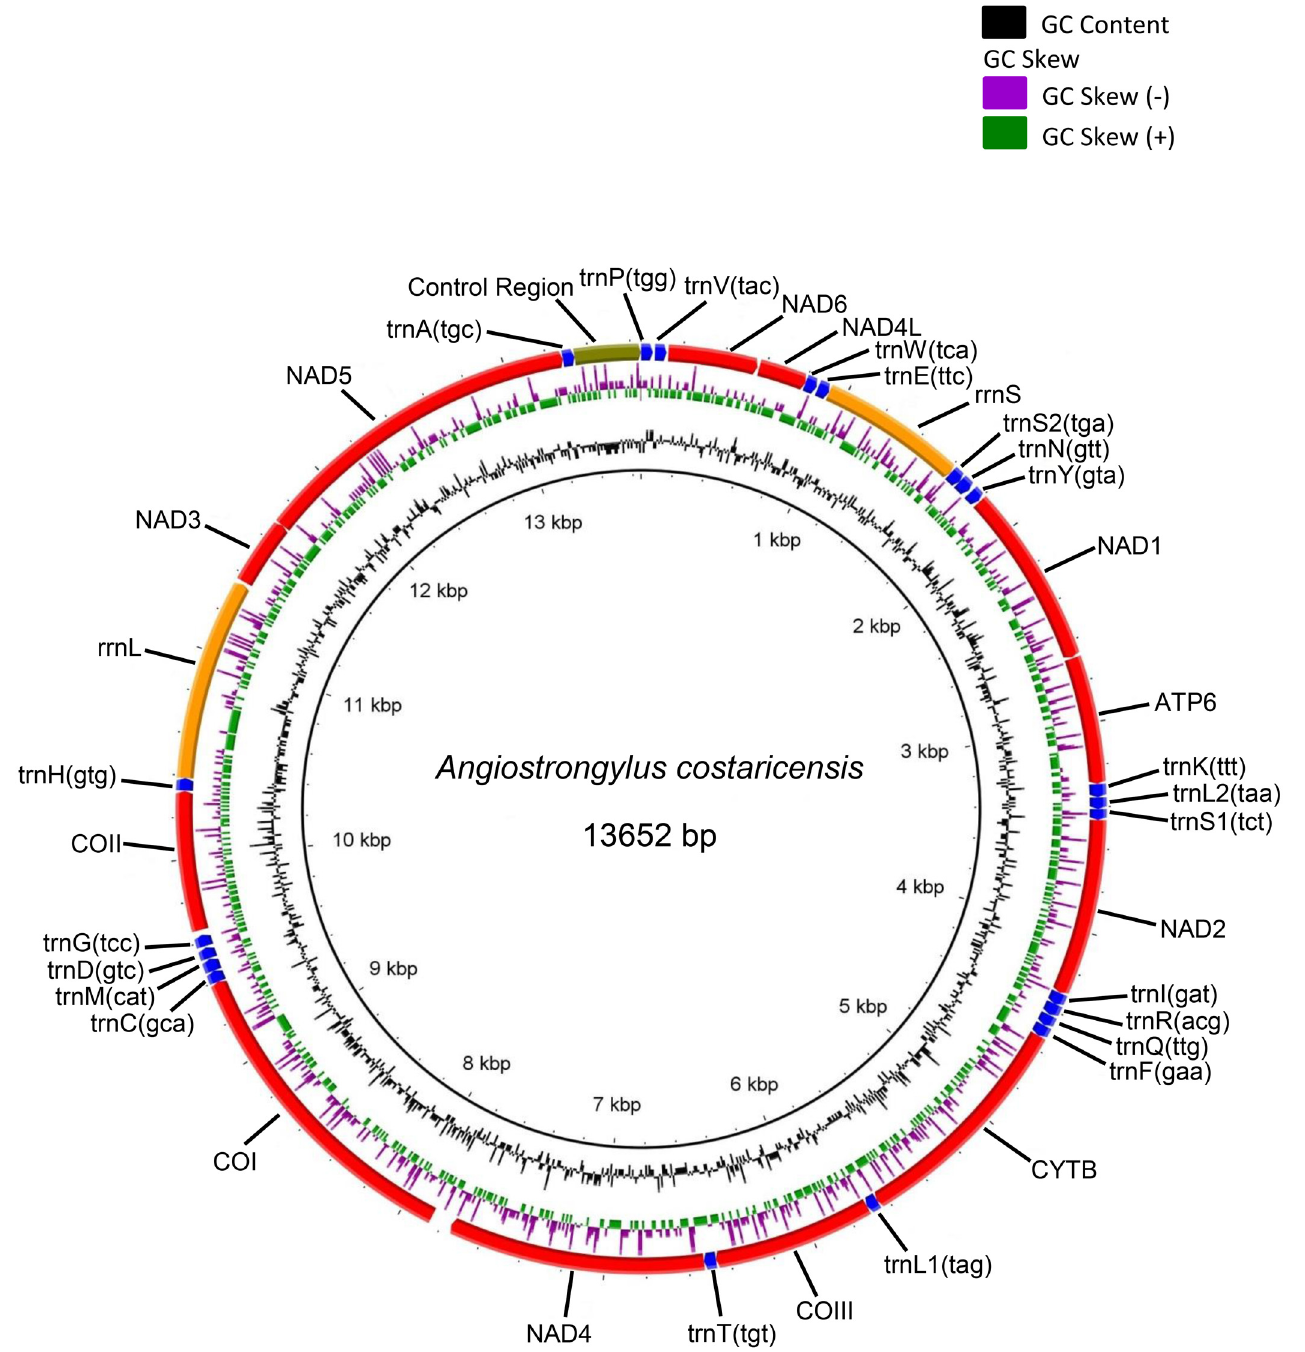
Fig 1. Complete mitogenome of Angiostrongylus costaricensis (Costa Rica taxon) with BRIG visualization showing the protein coding genes, rRNAs, tRNAs and non-coding regions. GC skew (0.498) is shown on the outer surface of the ring whereas GC content (25.1%) is shown on the inner surface. The AT skew is -0.287. The intergenic space between NAD4 and COI is 64 bp.